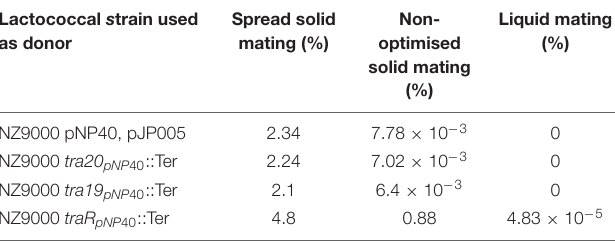
TABLE 5 | Conjugation frequencies obtained when using different strains as donors, using three different mating protocols: non-optimal solid mating, liquid mating, and spread solid mating.